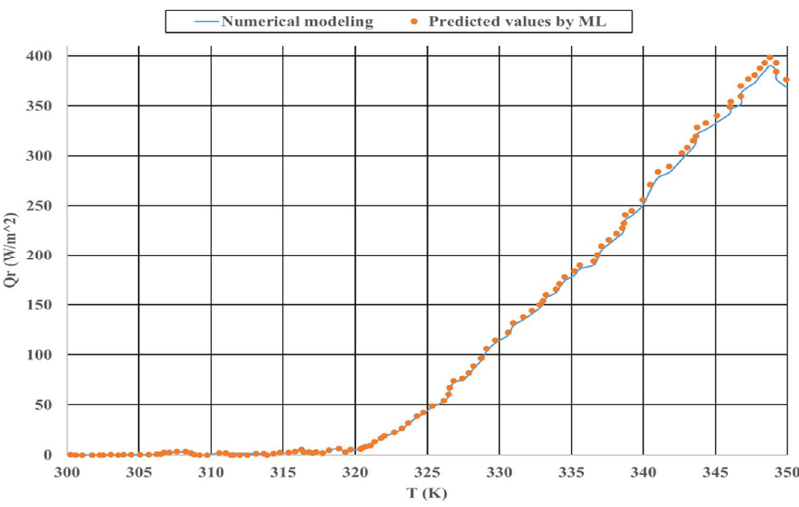
Figure 10. Comparison between the two utilized different methods.